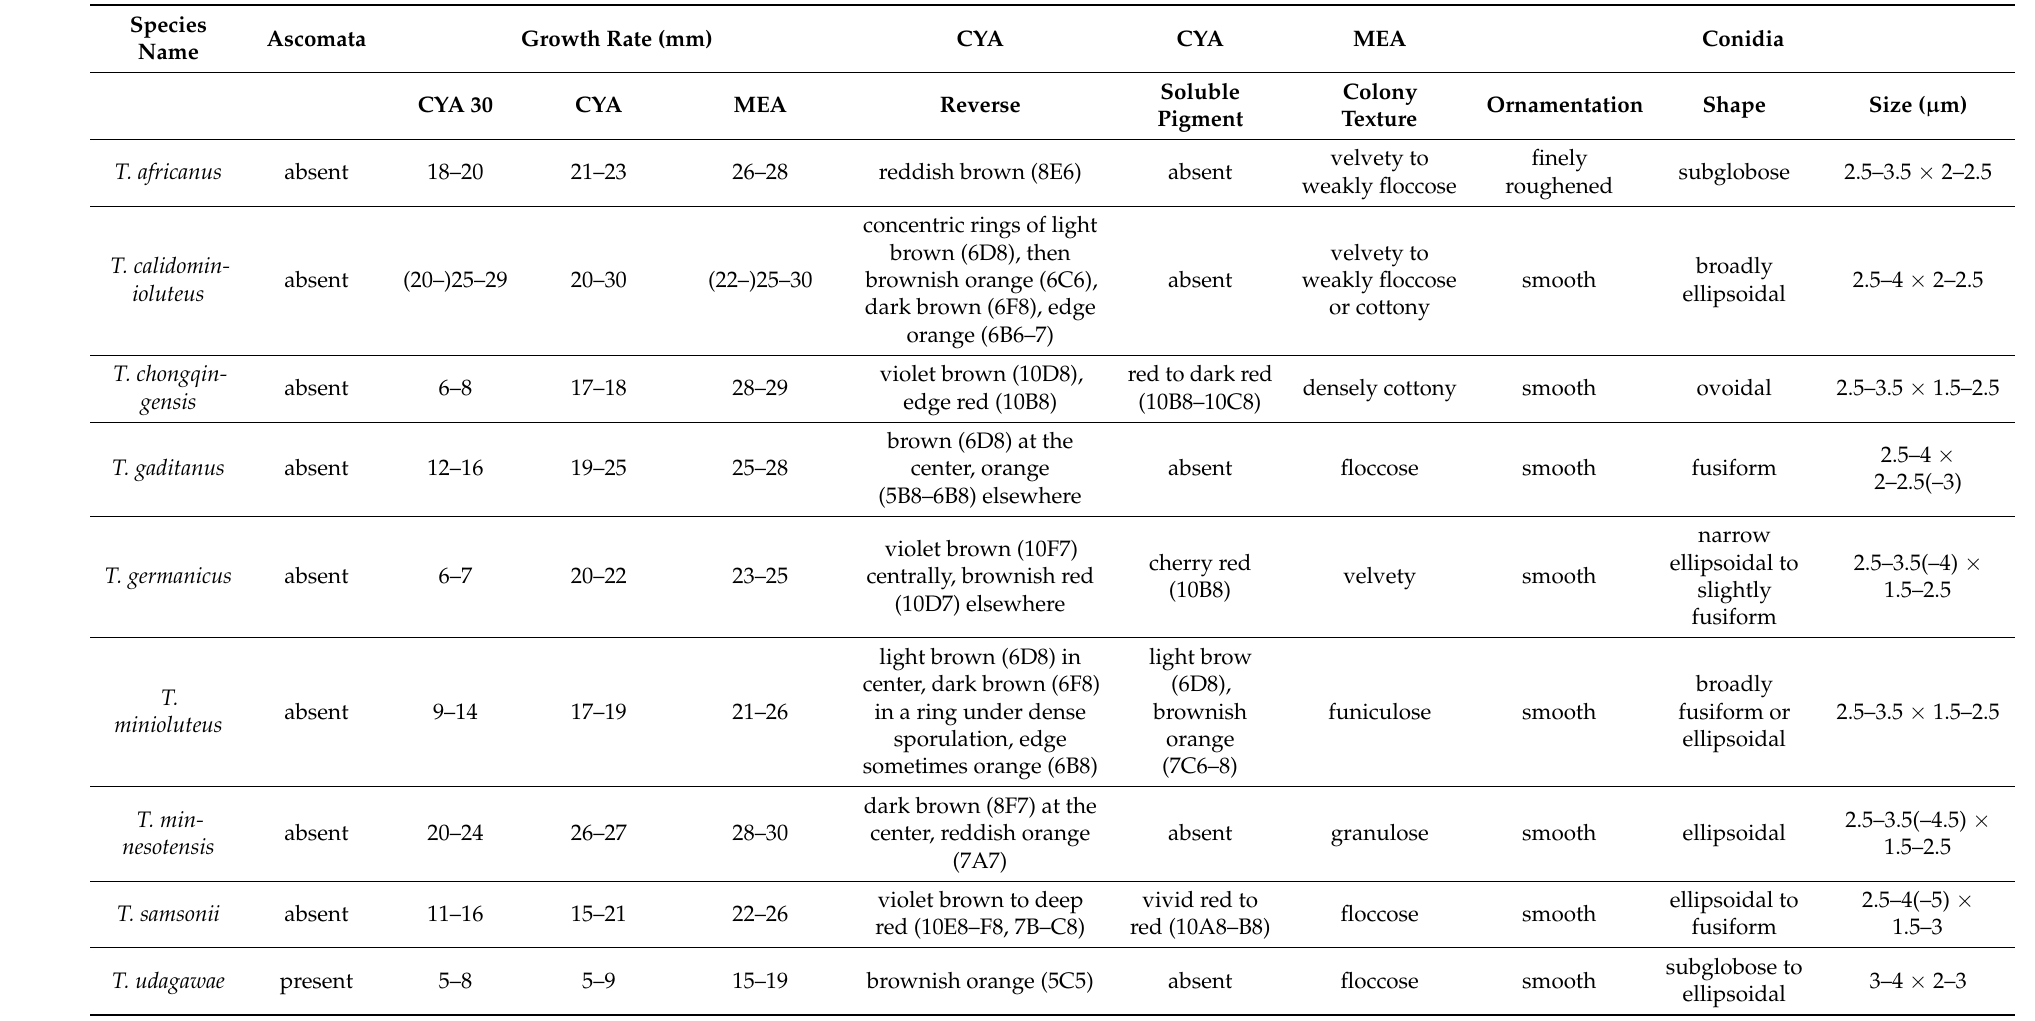
Table 2. Overview of microscopic features and colony characters on various